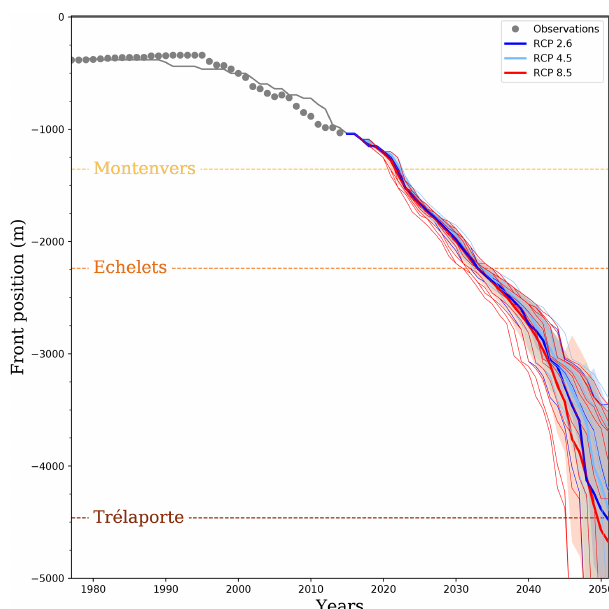
Figure 6. Evolution of the front position (along a flow line defined by the front fluctuation). The hindcast is in gray, and the squares represent observations. Forecasts are shown in dark blue (RCP 2.6), blue (RCP 4.5) and red (RCP 8.5) with average forecasts repre- sented by thick curves with 1 σ uncertainty